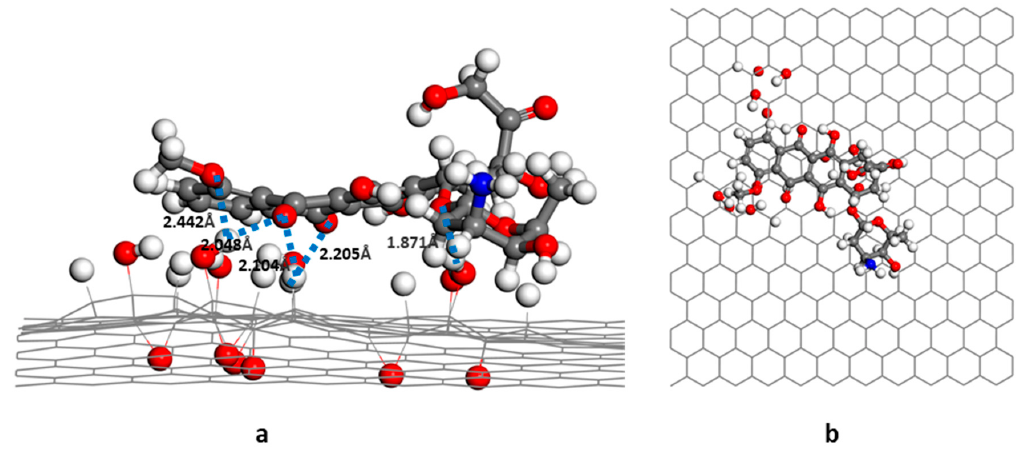
Figure 5. Energy-minimized structure of GO-OH-DOX; ( a ) side view; ( b ) top view.